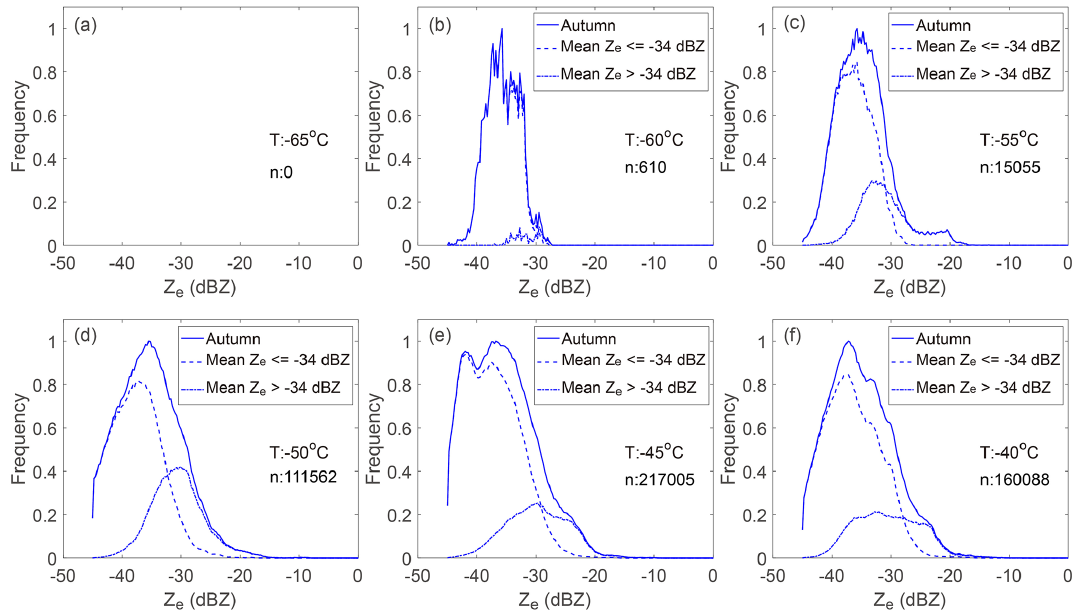
Figure 10. As in Fig. 8 but for autumn. No cirrus clouds are found when the temperature is at or below − 65 ◦ C in autumn.